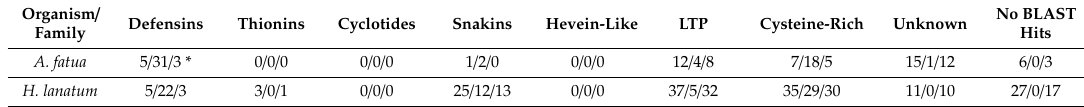
Table 1. Example distributions of potential AMPs among peptide families.